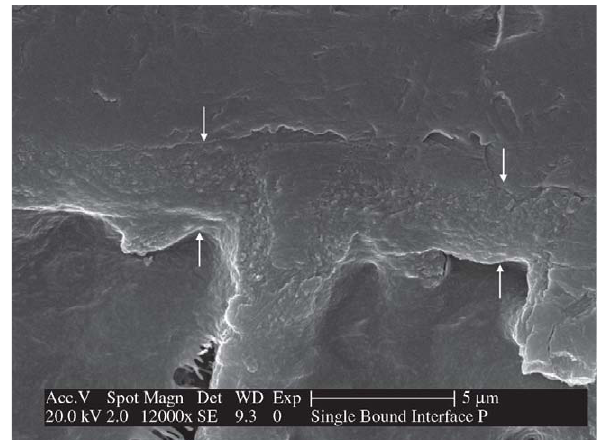
Figure 1. SEM micrograph of resin-dentin interface created by Adper Scotchbond Multi Purpose Plus. The hybrid layer (arrows) and the resin tag formation can be observed.